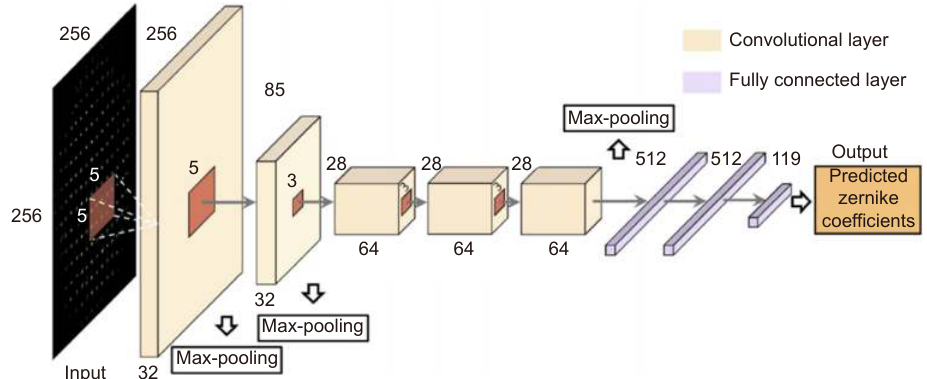
Fig. 7 | Architecture of LSHWS. The network contains five convolutional layers and three full connected layers. The input is a SHWFS image of size 256×256. The output is a vector of size 119, which represents Zernike coefficients. Figure reproduced from ref. 76 , Optical Society of America. Table 2 | The correlation coefficient of SHWFS patterns and the Strehl ratio of PSFs. Table reproduced from ref. 76 , Optical Society of America. Correction